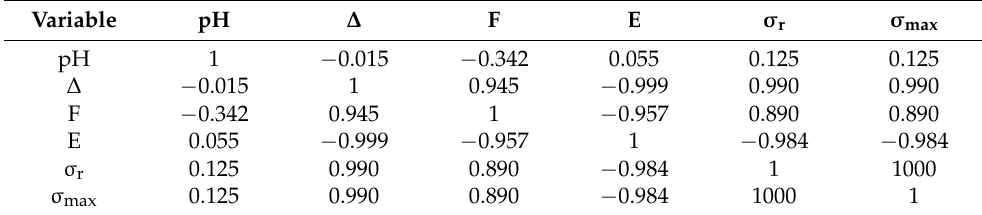
Table 7. pH–axial stress correlation coefficients (Pearson correlation